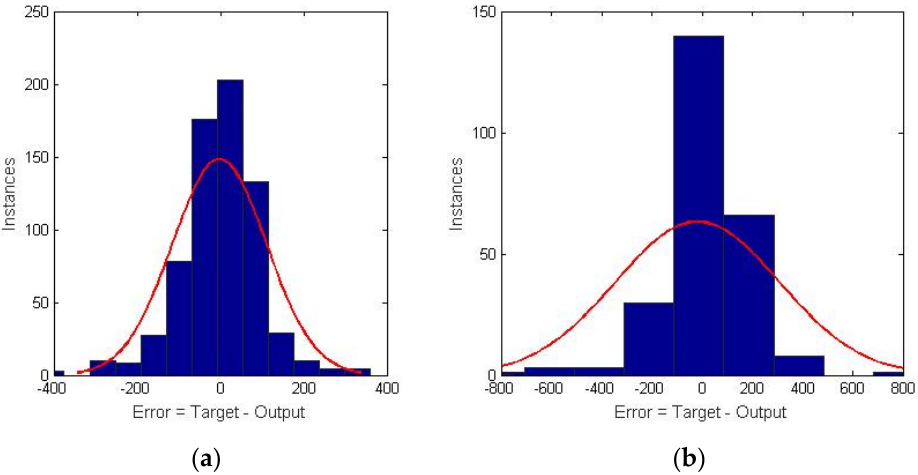
Figure 13. ( a ) Household No 85—Working days forecast error distribution; ( b ) household No 85—Weekend forecast error distribution.